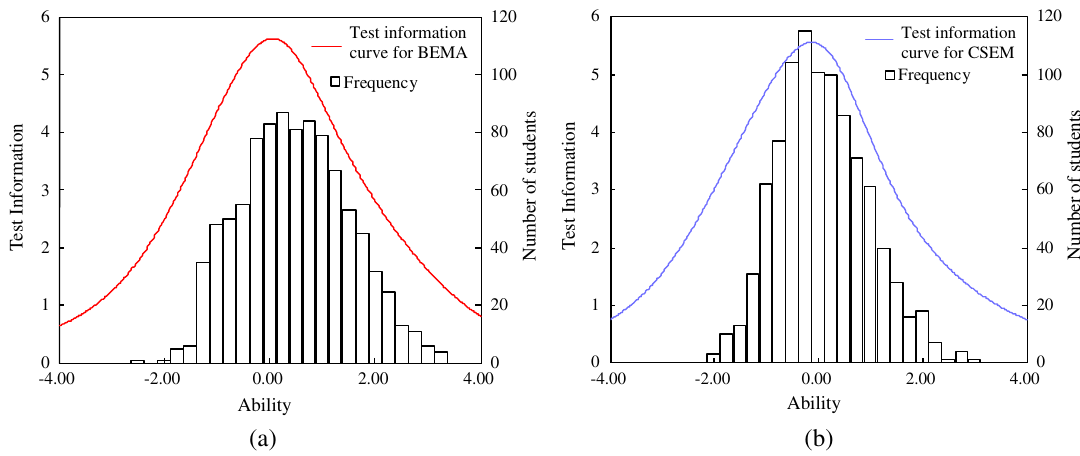
FIG. 6. Distributions of students ’ estimated abilities (histogram) and test information curves (line) for (a) BEMA and (b) CSEM. The histogram of students ’ estimated ability is overlaid with the corresponding test information curve. In Fig. 6(a), the BEMA scale has been transformed to the CSEM scale. All plots show that the bulk of the students are located in the central region of ability, which has the best feature to produce good estimates.